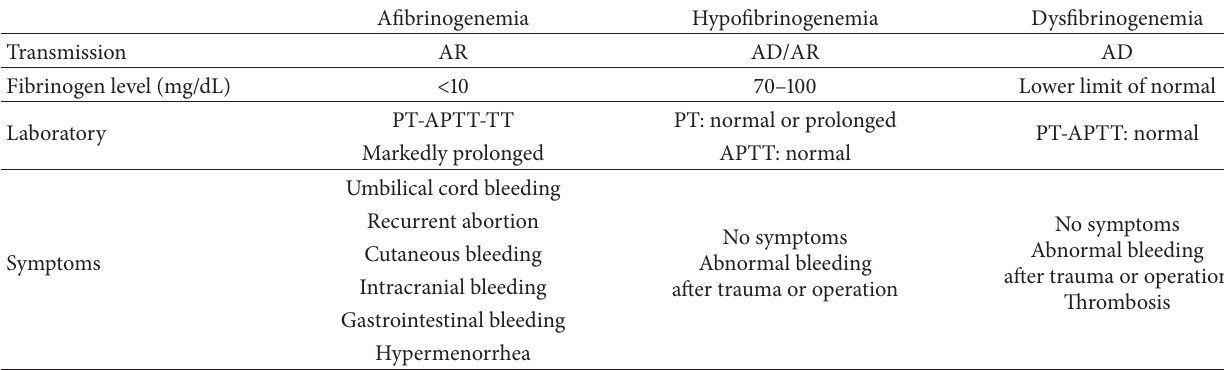
Table 1: Characteristics of inherited fibrinogen disorders.